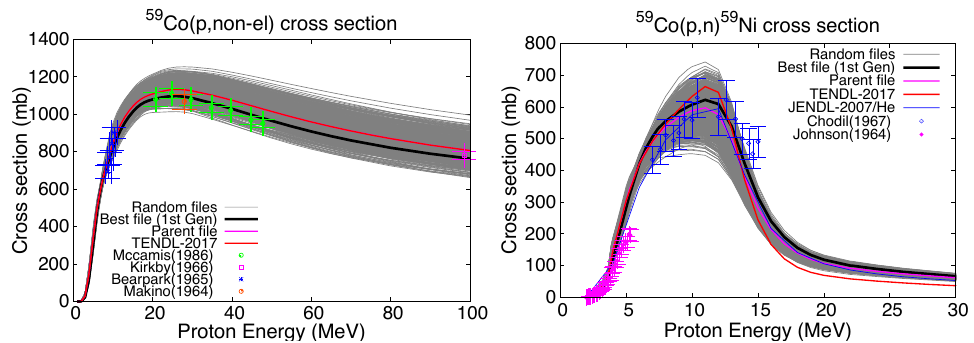
Figure 2. Comparison of file performance between the evaluations from this work and the TENDL-2017 library for the (p,non-el), (p,n) cross sections of 59 Co. Comparisons are made with the JENDL / He-2007 library in cases where evaluations are available. Only the experimental data sets used in the adjustment have been presented.